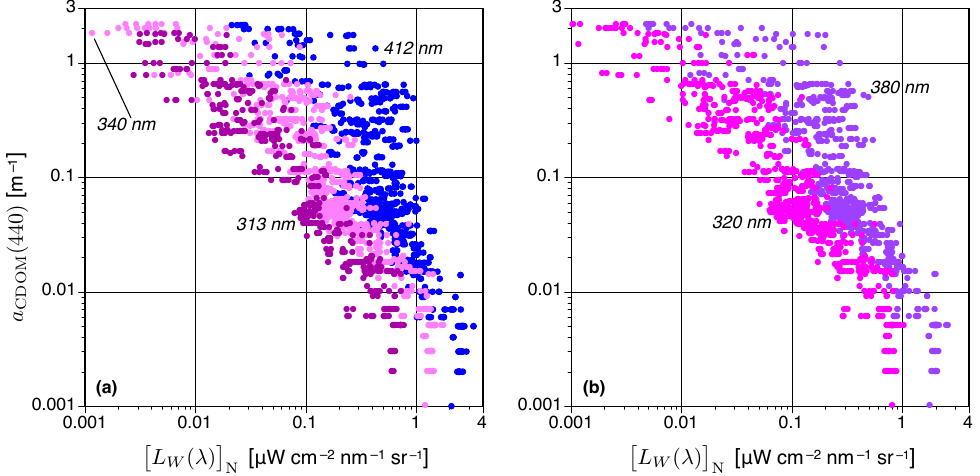
L W ( λ ) algorithms to derive N (cid:2) (cid:3) L W ( λ ) algorithms plus the N (cid:2) (cid:3)